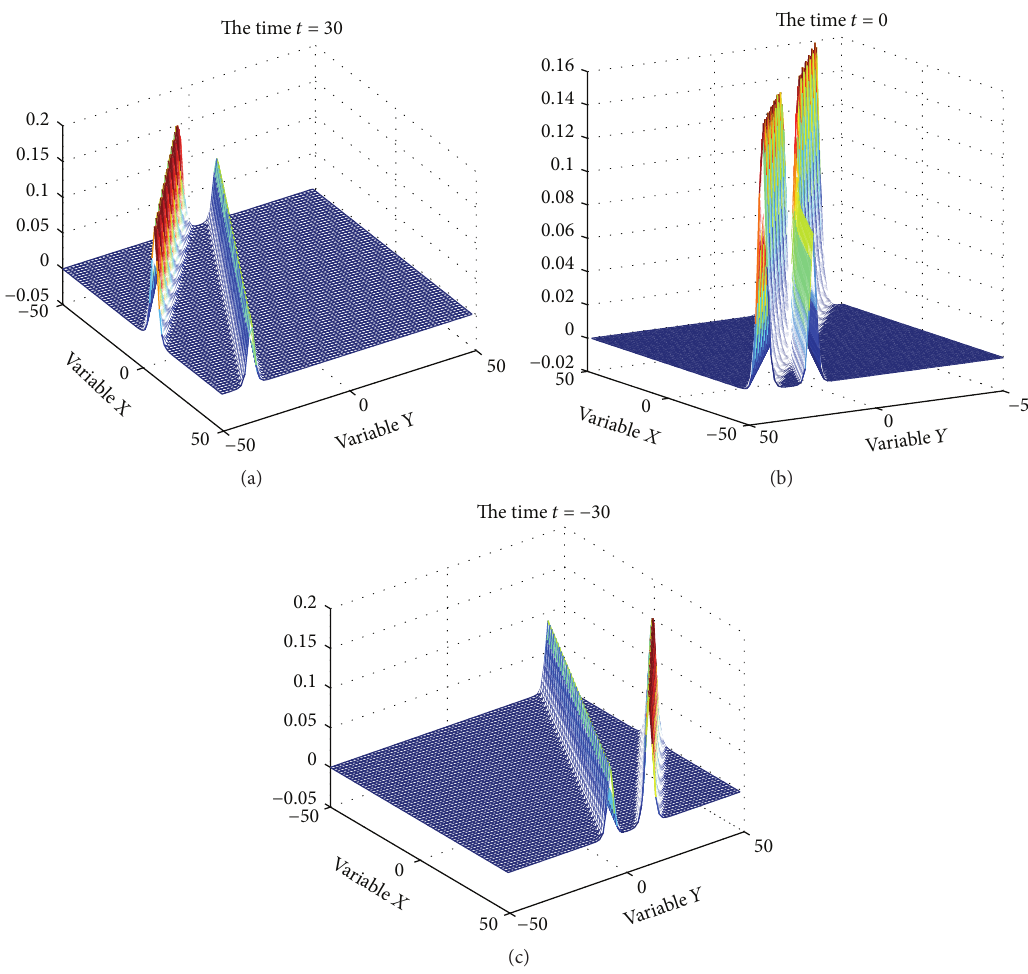
Figure 4: The process of (27) with 𝑘 1 = 0.8 , 𝑘 2 = 0.6 , 𝑝 1 = 1.25 , 𝑝 2 = 2 , 𝑐(𝑡) = 30 , 𝑏(𝑡) = 1 , and ℎ(𝑡) = 1 , and (a) implies 𝑡 = 30 , (b) implies 𝑡 = 0 , and (c) implies 𝑡 = −30